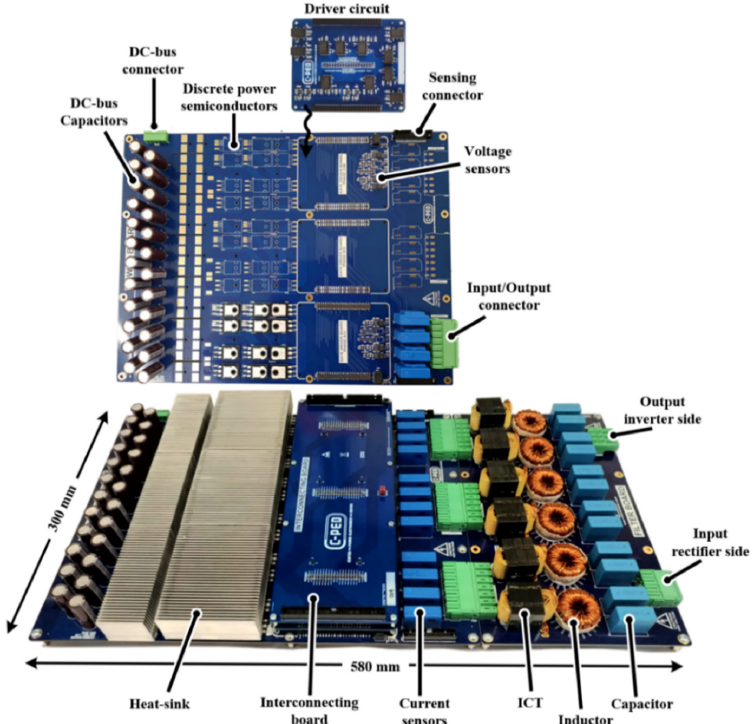
Figure 9. Prototype of the 3 Φ 5L E-Type Rectifier and Inverter including the input and output power